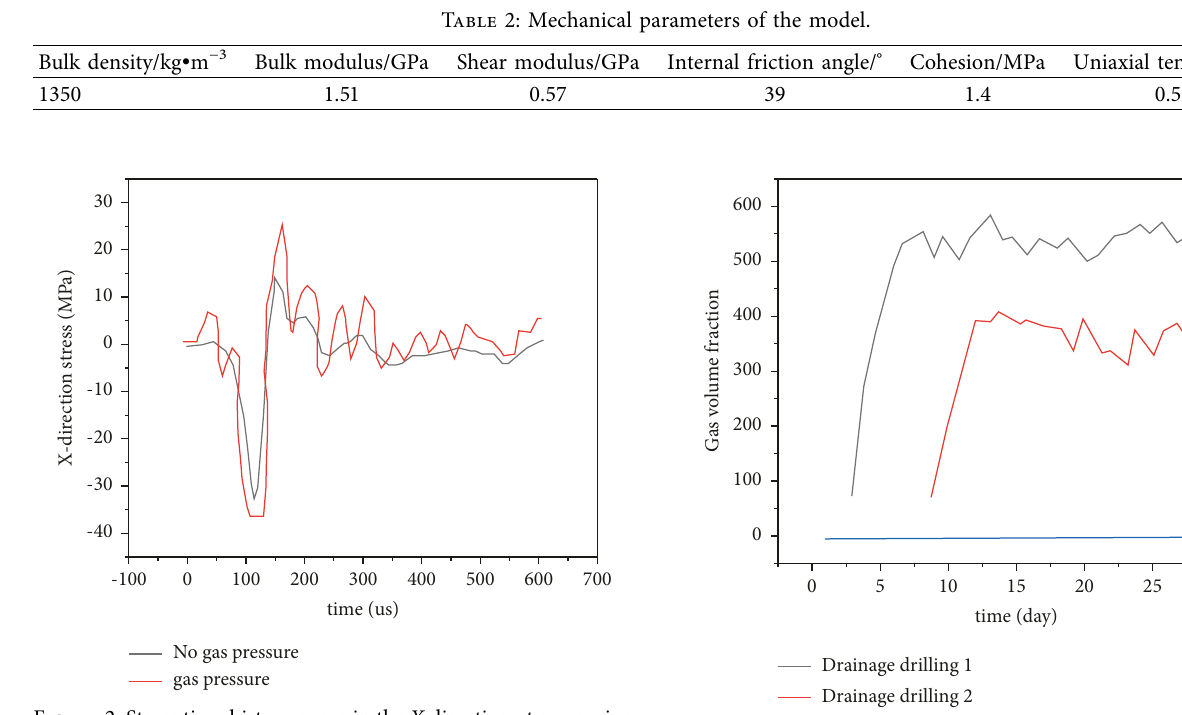
Figure 2: Stress time history curve in the X direction at measuring point A.